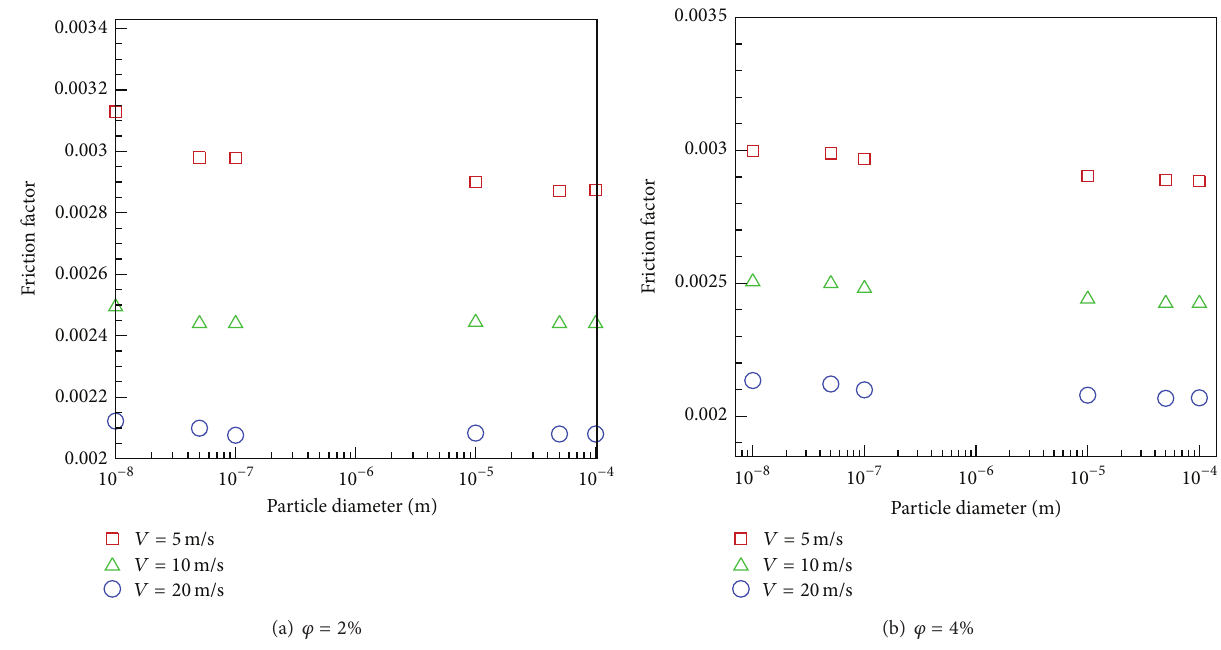
Figure 9: The variation of particle size with average friction